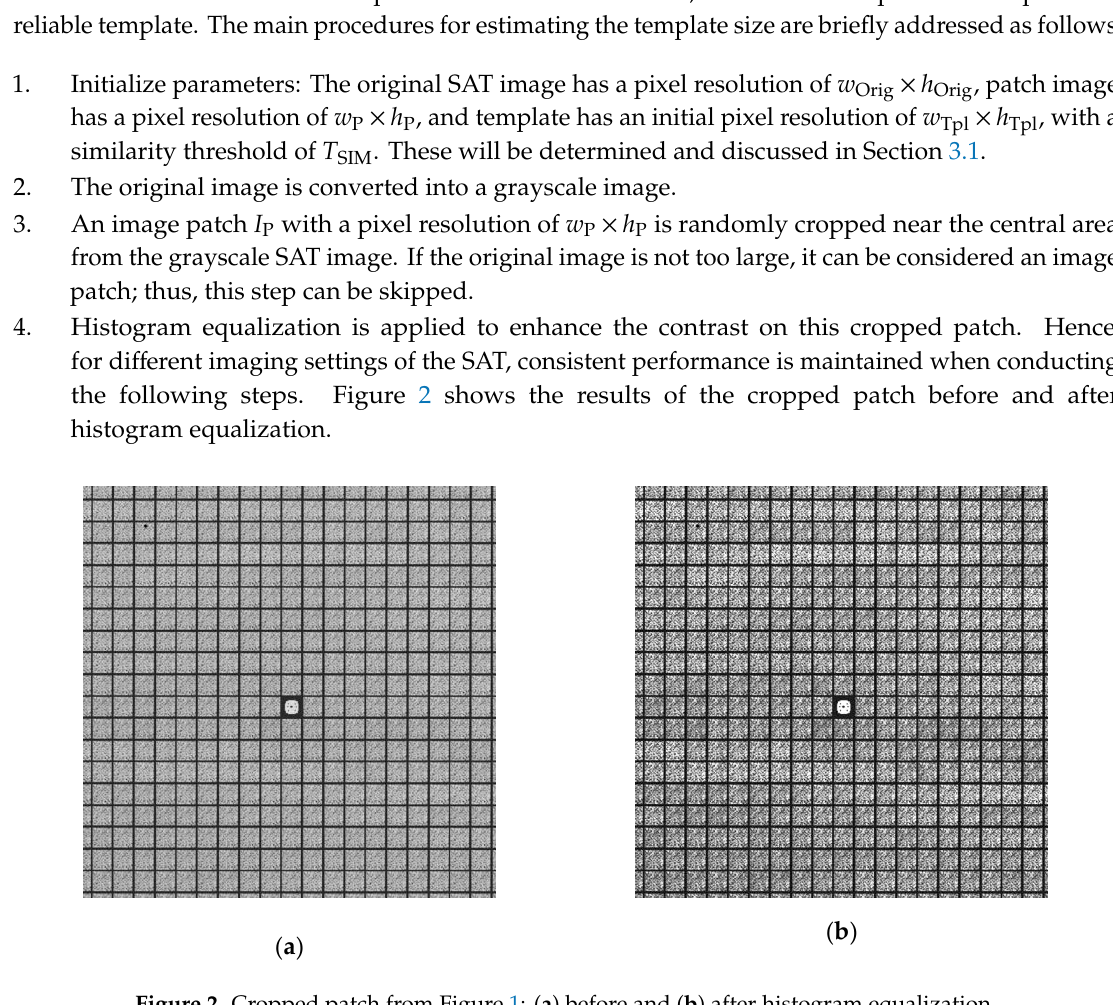
Figure 2. Cropped patch from Figure 1: ( a ) before and ( b ) after histogram equalization.